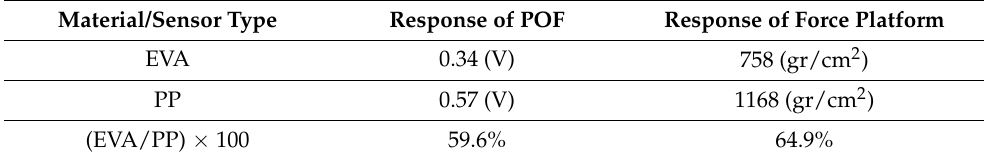
Table 2. Response of the force platform and POF with different insole materials at the